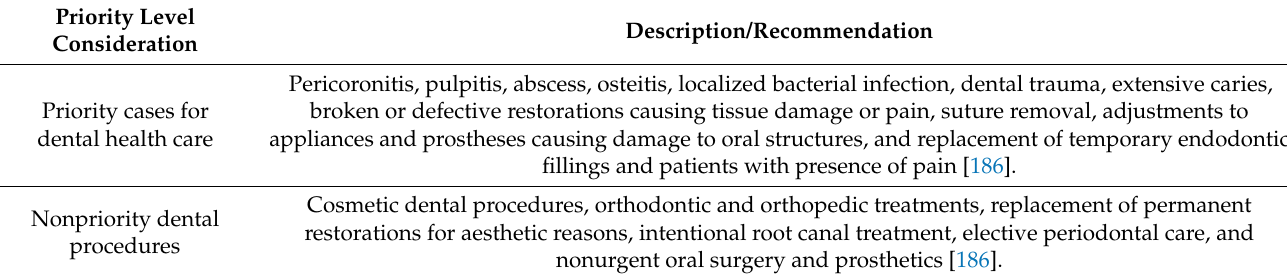
Table 2. Recommendations and procedures that should be performed during dental care throughout the COVID-19